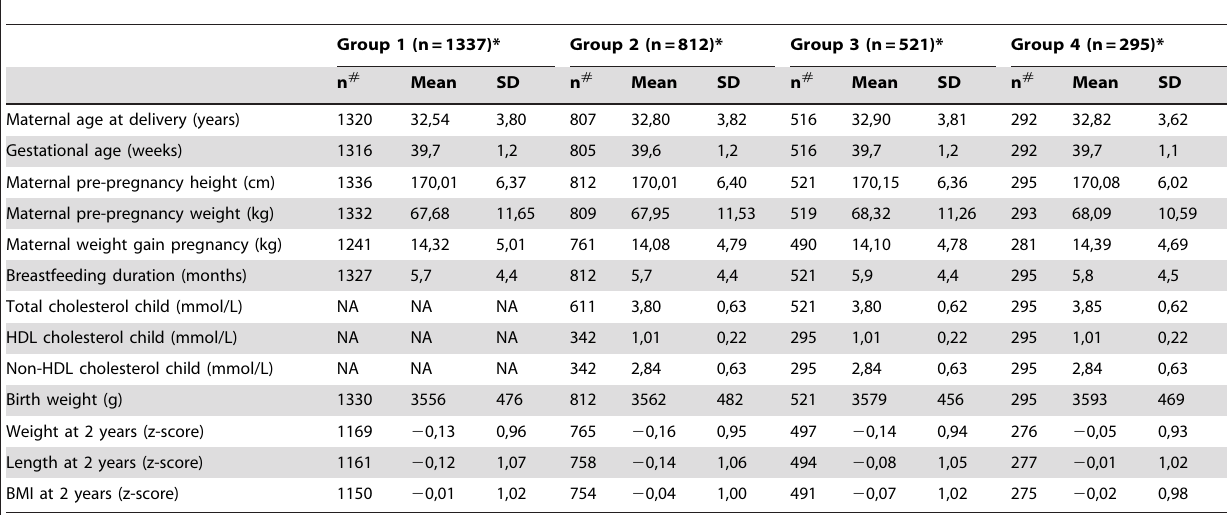
Table 3. Representativeness of the study participants regarding continuous variables.